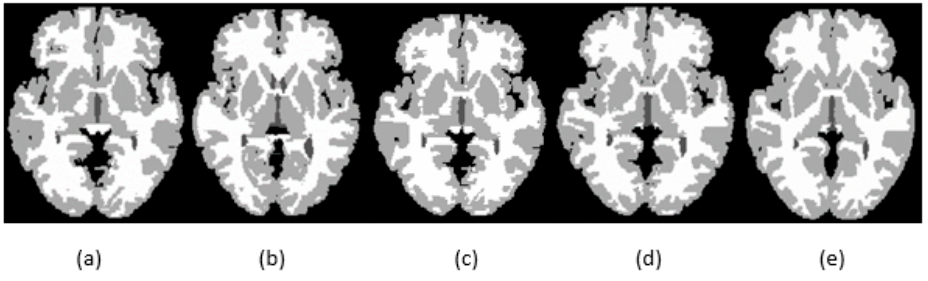
Figure 6. Segmentation results for GM, CSF, and WM for existing methods and the proposed method using IBSR_11: ( a ) segmentation results generated by SegNet; ( b ) segmentation results generated by U-net; ( c ) segmentation results generated by MultiRes + UNet; ( d ) segmentation results generated by the proposed method; ( e ) ground-truth segmentation map.